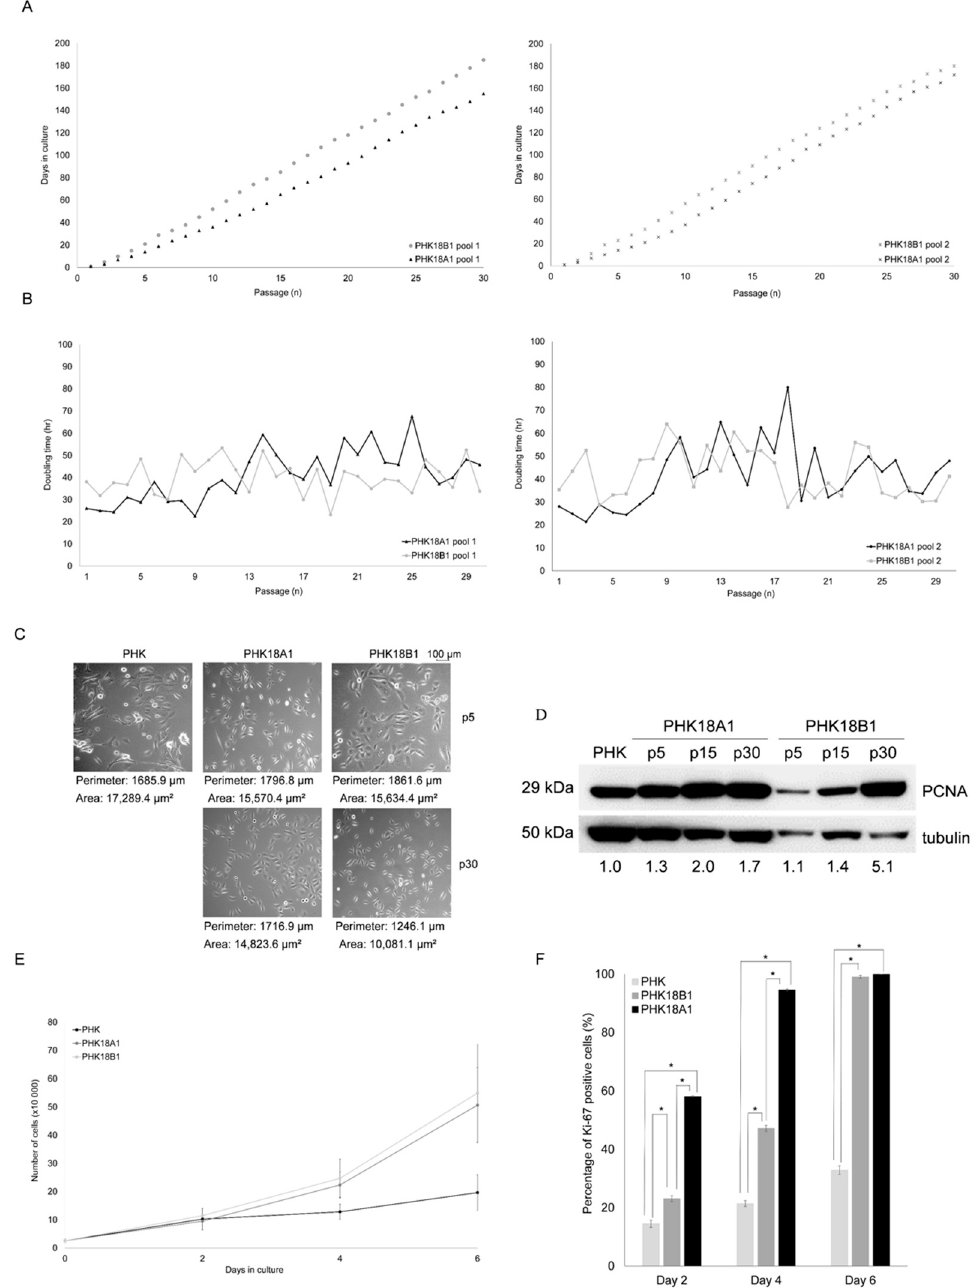
Figure 1. Proliferation kinetics of PHKs transducing E6/E7 of HPV-18 A1 (PHK18A1) or B1 (PHK18B1) sublineage variants: ( A ) number of passages per day in culture using two different batches of PHK pools. Each point represents a passage in culture. The same number of cells was plated at each passage. T -test was used to compare the two different PHK batches transducing the same HPV-18 variant, or to compare the same batch of PHKs transducing the different variants; ( B ) doubling time in hours of PHK18A1 and PHK18B1 along passages in culture; ( C ) morphology of parental PHK#1 ( p 5), PHK18A1, and PHK18B1 in low passage ( p 5) and after immortalization ( p 30) in 10 × magnification; ( D ) PCNA levels. Overall, 60 µ g of protein extracts were fractionated in SDS-PAGE and PCNA levels were accessed using Western blotting. Tubulin levels were evaluated for loading control. A representative of three independent assays is presented; ( E ) proliferation rates. Cells counting was performed every other day for six days. Means and the standard error of three experiments carried out independently in triplicate are presented; ( F ) percentage of Ki-67 positive cells over six days in culture. Cells from ( E ) were fixed, incubated with anti-Ki-67, and analyzed by flow cytometry. * p = 0.00.